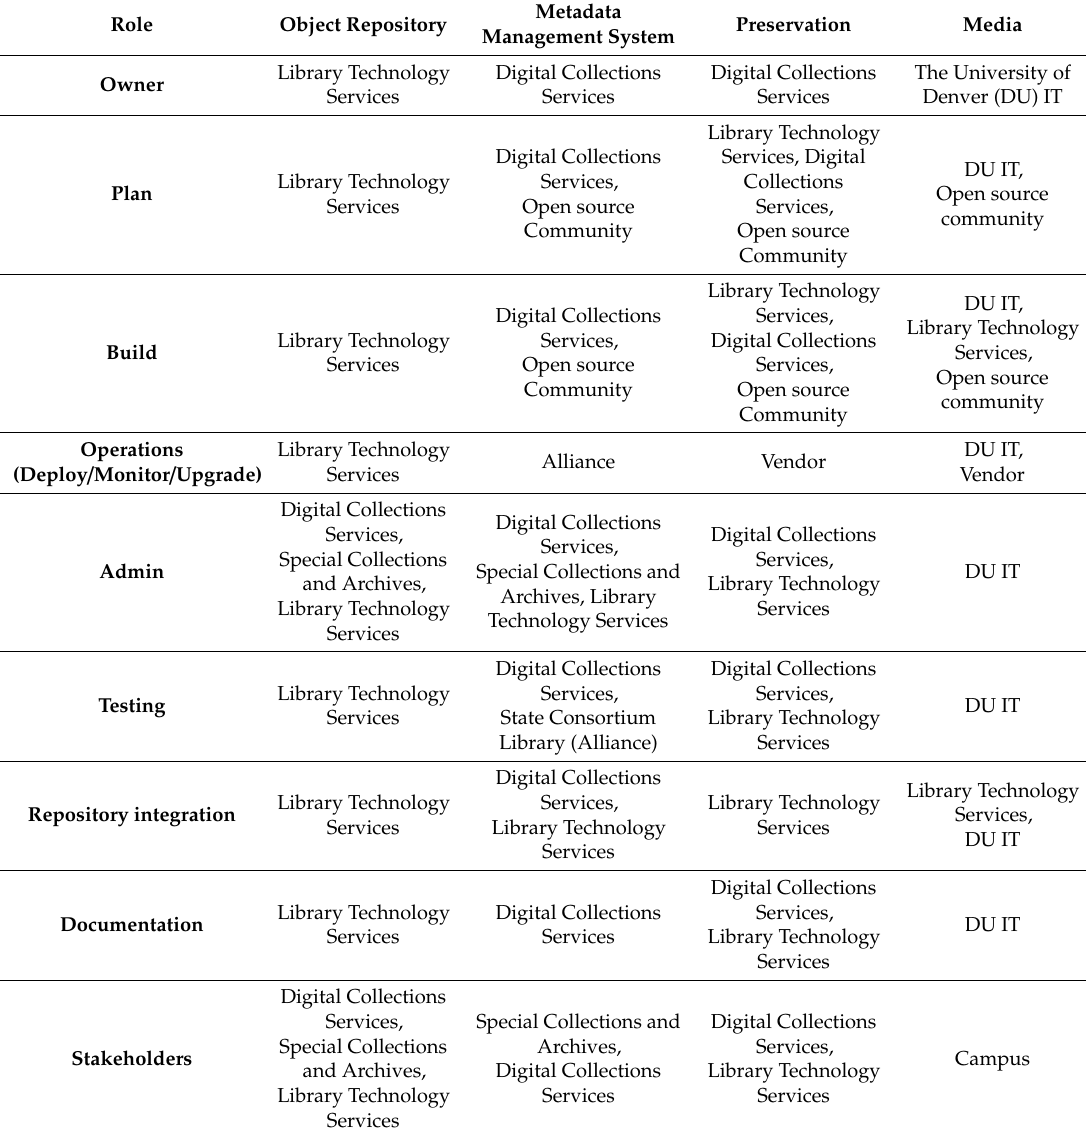
Table 1. Vertical Cooperation